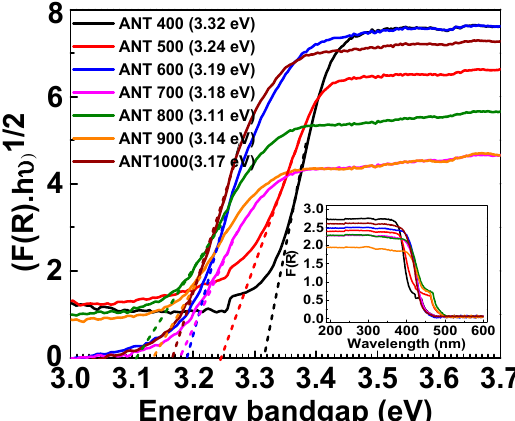
Figure 14. Tauc’s plot for an indirect bandgap model (Kubelka-Munk function) and UV-visible diffusive reflectance spectra (inset) of annealed anatase TNPs. The dash-dot lines represent line tangent towards the point, where the line intersected the horizontal energy axis (bandgap). The observed bandgap of controllably annealed anatase TNPs is mentioned in brackets, followed by the sample name. The bandgap measured by the slope of the Tauc’s curve linearly extended towards the point where the line intersected the horizontal energy axis by means of the subsequent Tauc’s plot appearance when supposing that the anatase TNPs were indirect bandgap